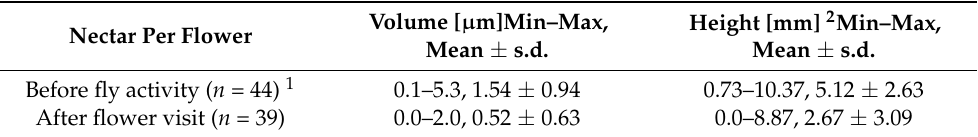
Table 3. Measured nectar volumes in flowers of Babiana vanzijliae (Iridaceae) before and after flower visits of Prosoeca marinusi (Nemestrinidae) and calculated nectar heights inside the perianth tube. Nectar Per